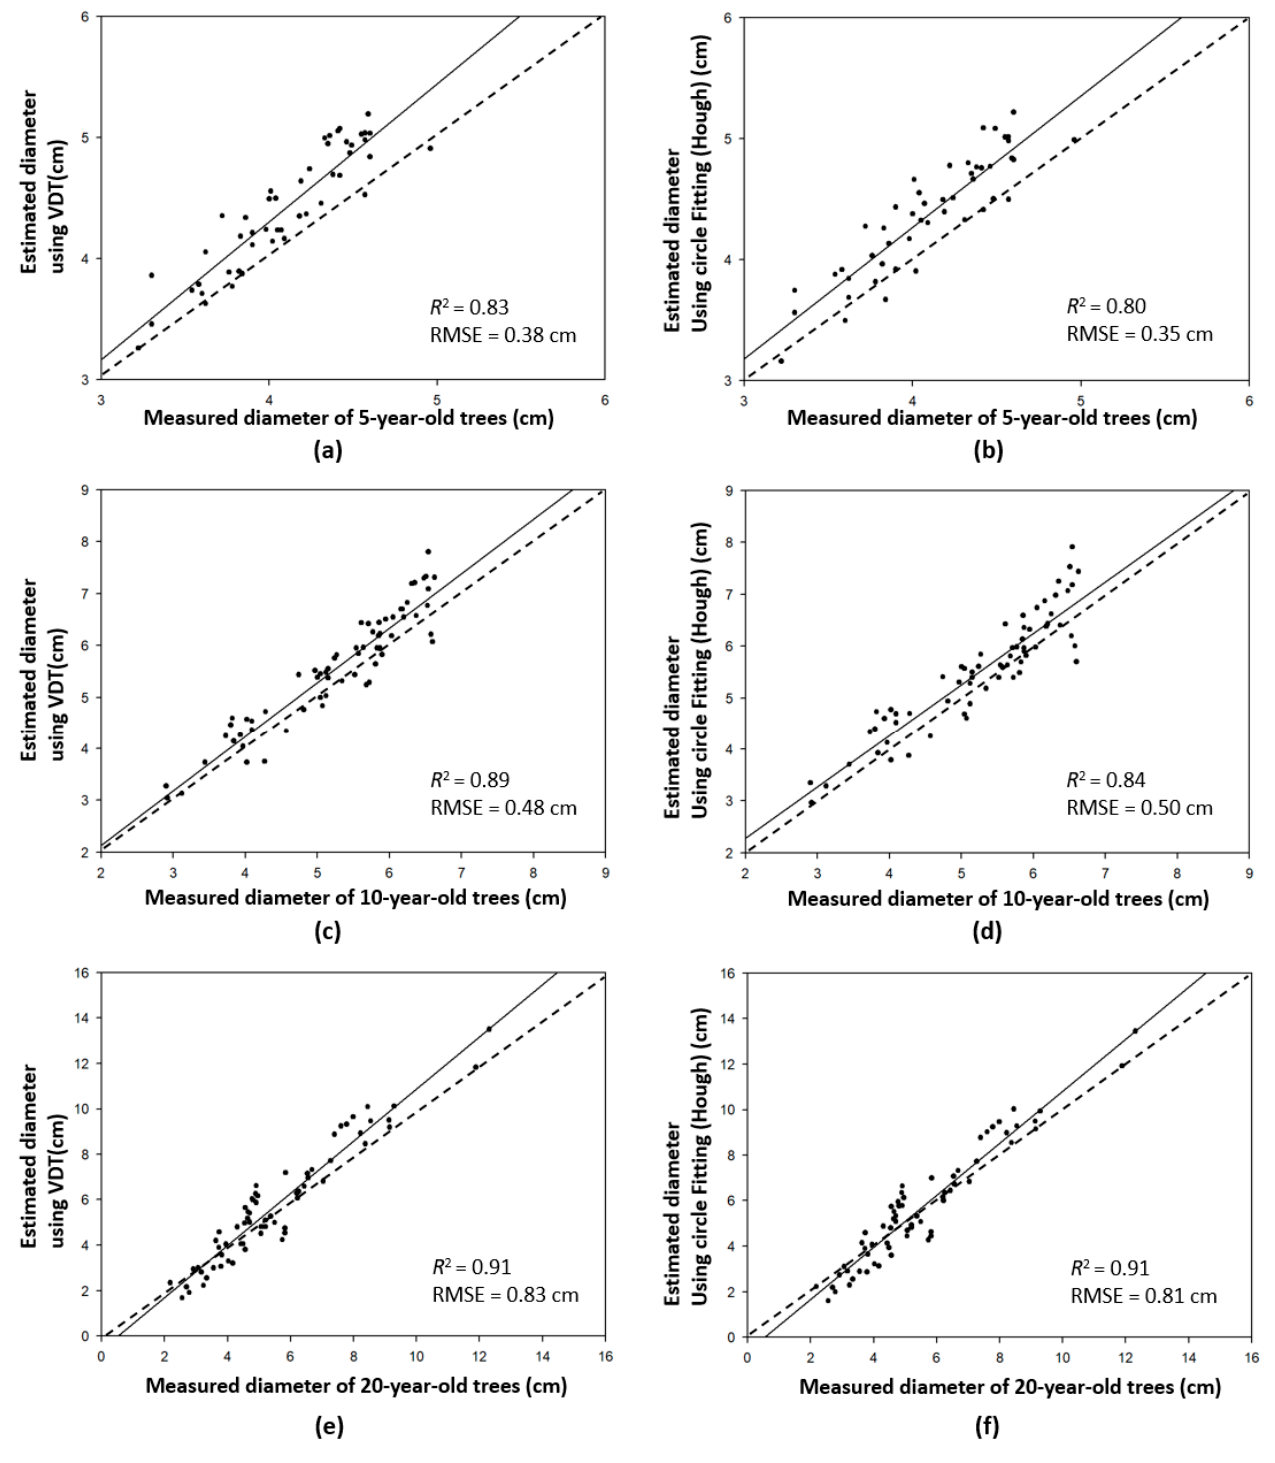
Figure 9. The results of estimations for the base diameter of the first order branches of three sample plots. ( a ) VDT measurement of a 5-year-old sample plot; ( b ) cylinder fitting (Hough) processing of a 5-year-old sample plot; ( c ) VDT measurement of a 10-year-old sample plot; ( d ) cylinder fitting (Hough) processing of a 10-year-old sample plot; ( e ) VDT measurement of a 20-year-old sample plot; ( f ) cylinder fitting (Hough) processing of a 20-year-old sample plot. In the figure, VDT refers to virtual diameter tape; R 2 refers to the coefficient of determination; RMSE refers to the root mean square error.